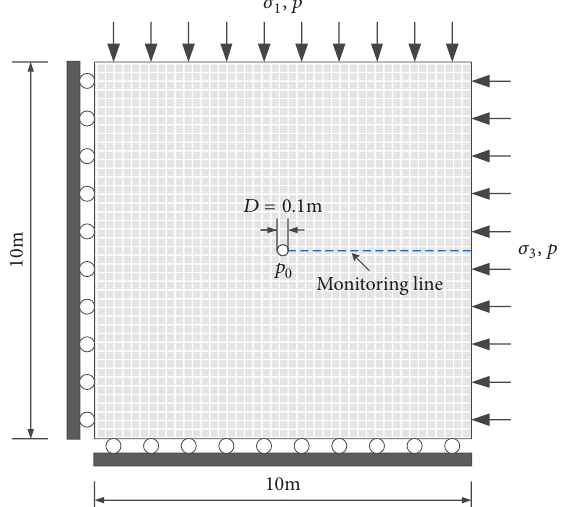
Figure 6: Comparison between numerical results and analytical results of damage.